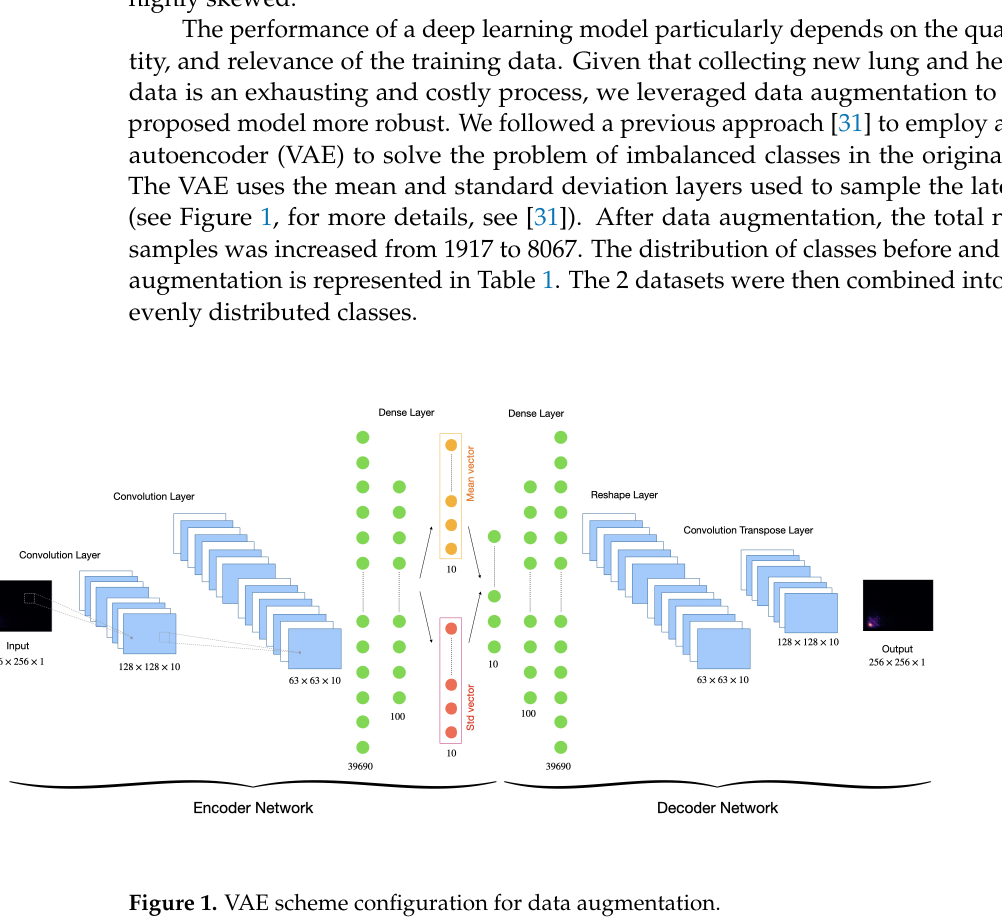
Figure 1. VAE scheme configuration for data